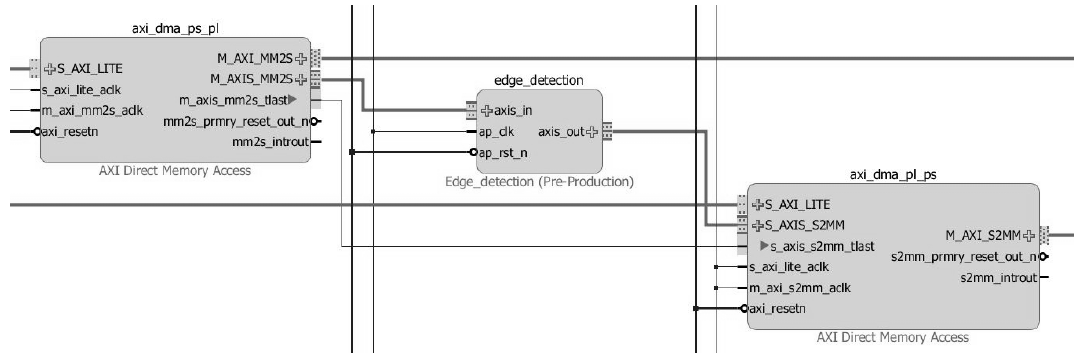
Figure 5. AXI Direct Memory Access (AXI DMA) connections, which provide a high-bandwidth direct memory access between memory and AXI4-Stream-type edge detection peripheral.